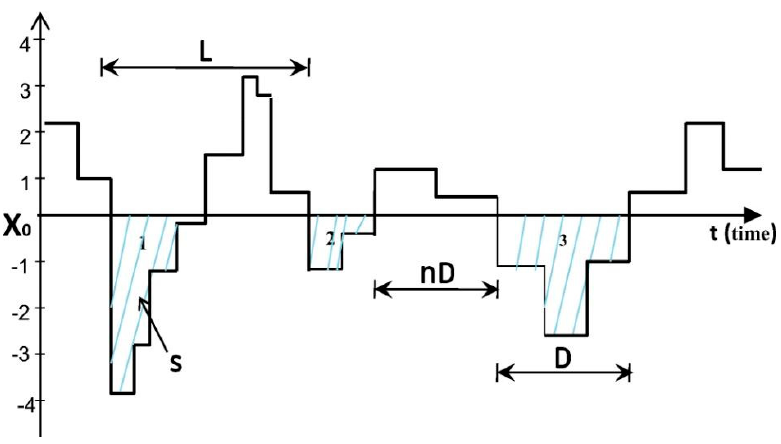
Figure 2. Calculation scheme of drought Severity (S), Duration (D), non-occurrence of drought (nD) and length (L) of drought and non-drought periods using the Run Theory method.